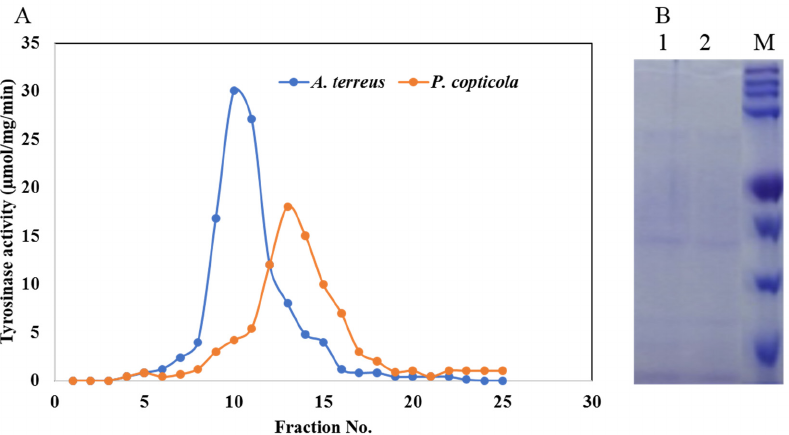
Figure 3. Purification profile of tyrosinase from A. terreus and P. copticola with different chromatographic approaches. The experimented fungal cultures were incubated at the desired conditions for tyrosinase production, the fungal tissues were pulverized in liquid nitrogen and the intracellular proteins were extracted, used as a source of crude enzyme as described in Materials and Methods. ( A ) The precipitated crude tyrosinases from both fungal isolates were purified by gel filtration chromatography with Sepadex-G-200 column from A. terreus and P. copticola . The molecular subunit structure of the purified tyrosinase after the last purification step, was checked by the SDS-PAGE ( B ). M, Protein ladder (xxx), 1 A. terreus and 2 P. copticola purified tyrosinase.